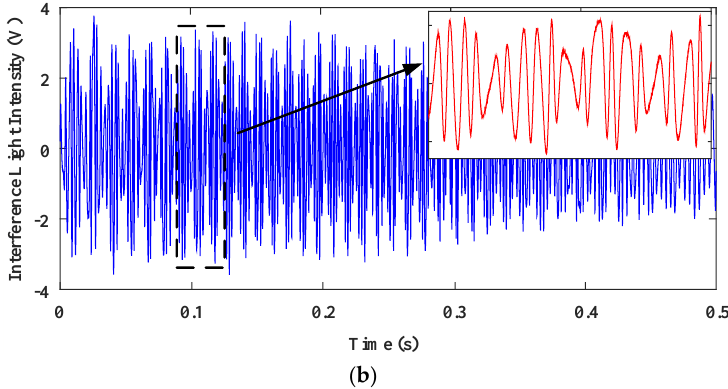
Figure 20. The interferogram signals acquired in time domain with PID control. ( a ) Reference light. ( b ) Testing light.